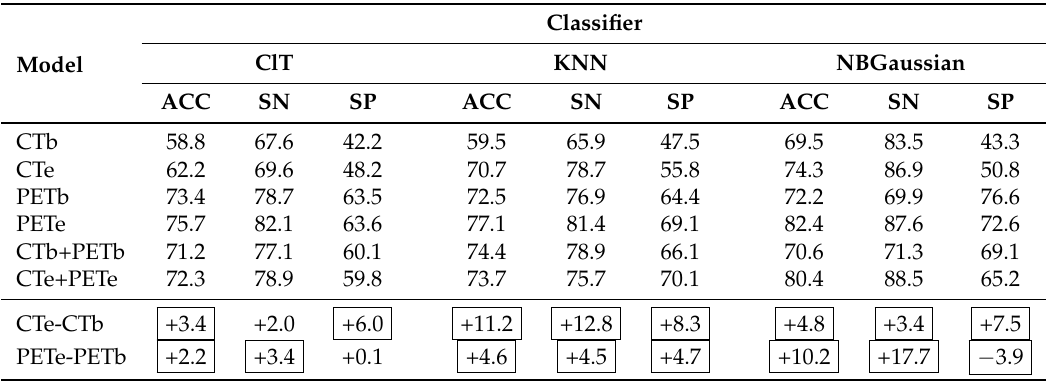
Table 5. Estimated performance of the different combination feature sets/classifiers and pairwise differences. Key to symbols: “ACC” = accuracy, “SP” = specificity, “SN” = sensitivity. Values are in %, differences in percentage points. Boldface figures indicate significant differences. For a comparison: accuracy of a random classifier (blind to prior class probabilities) = 50%; with prior class probabilities =